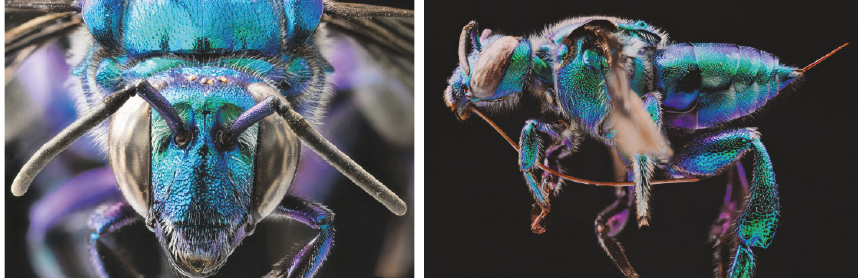
Figure 2: Female habitus and face of Exaerete lepeletieri .